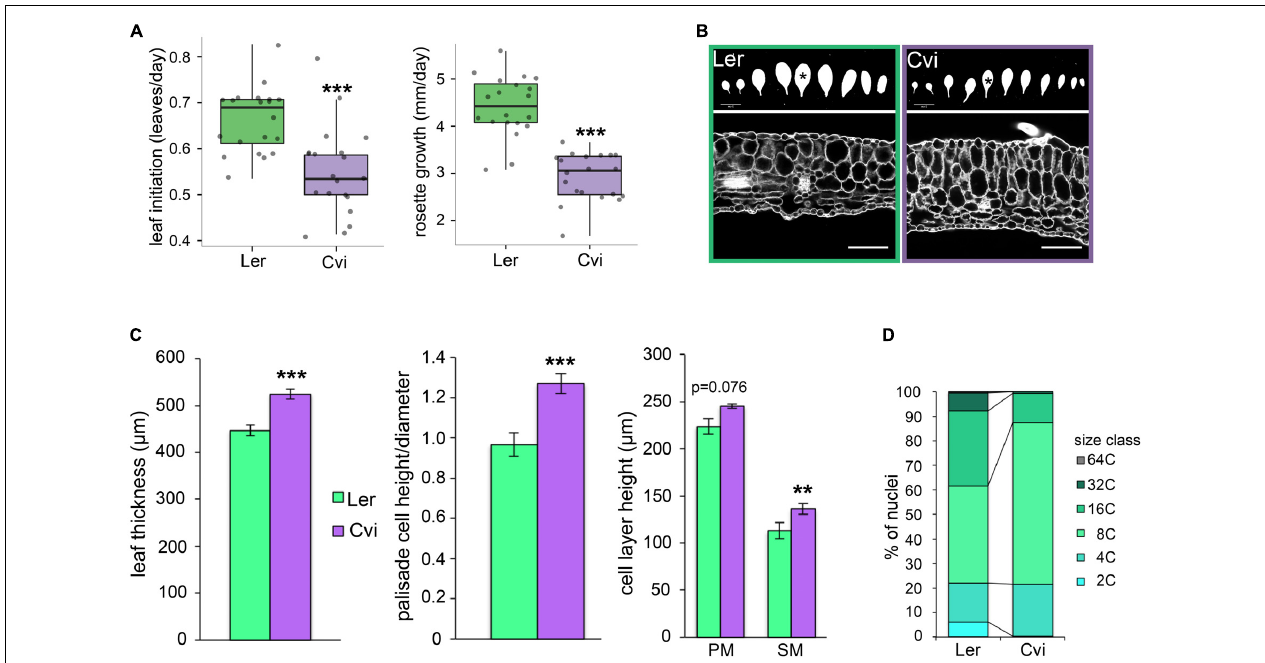
FIGURE 4 | Leaf growth rate and morphology comparisons between Ler and Cvi ecotypes. (A) The rates of leaf initiation and projected leaf area increase were quantified from time course top-view images of 20 plants per ecotype. (B) Representative images of rosette leaf silhouettes of each ecotype (upper). Leaf 5 was used for all measurements and is highlighted with an asterisk. Leaf 5 cross-sections showing typical morphology for each ecotype (lower). Scale bars are 2 cm for upper panel and 100 µ m for lower panel. (C) Leaf thickness, palisade cell dimensions, and the height of palisade and spongy mesophyll cell layers was quantified from leaf cross-section images ( n = 12). Bars denote standard error. (D) Distribution of relative nuclear sizes in Ler and Cvi leaves reflecting relative endopolyploidy ( n = 3). For (A,C) , ∗∗∗ p < 0.001; ∗∗ p <